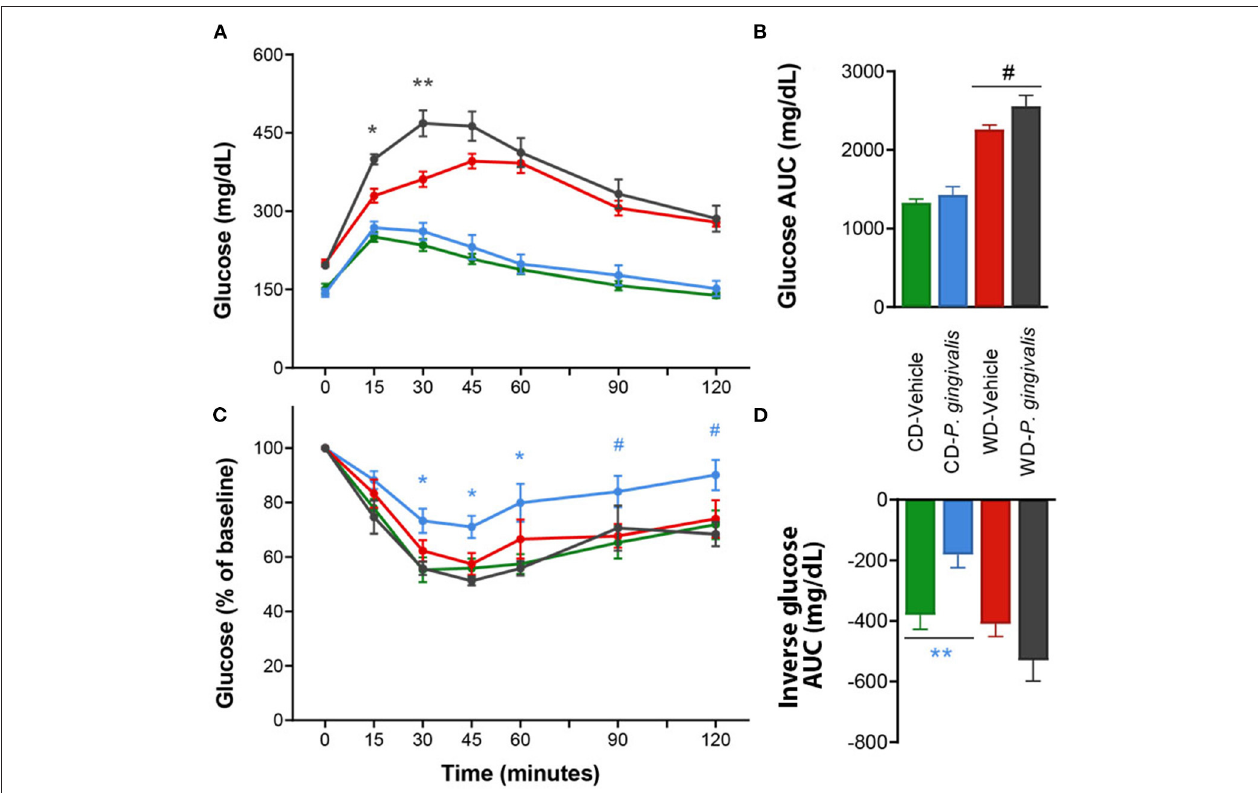
FIGURE 2 | Altered glucose tolerance following P. gingivalis infection. Intraperitoneal glucose tolerance test over time (A) and as total glucose area under the curve (AUC) (B) during the 120-min test. Intraperitoneal insulin tolerance test over time (C) and as total glucose AUC (D) . Repeated measures or one-way ANOVA with a Bonferroni post-hoc performed as appropriate. CD, control diet; WD, Western diet. Green = vehicle-treated mice fed a CD, blue = P. gingivalis -infected mice fed a CD; red = vehicle-treated mice fed a WD, black = P. gingivalis -infected mice fed a WD. Asterisks represent effect of P. gingivalis -infected vs. diet-matched, vehicle-treated group. # p = 0.10, * p < 0.05, ** p < 0.01. n =